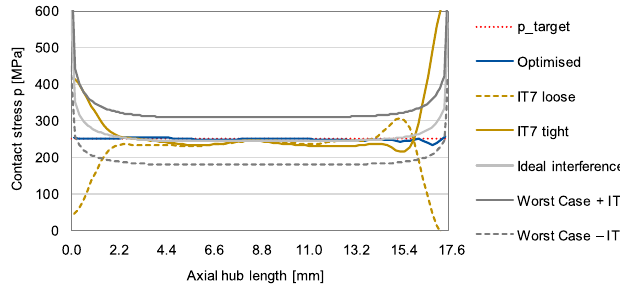
Fig. 12. Comparison of IT7 worst-case contact-stress distribu- tions to interference- fi t